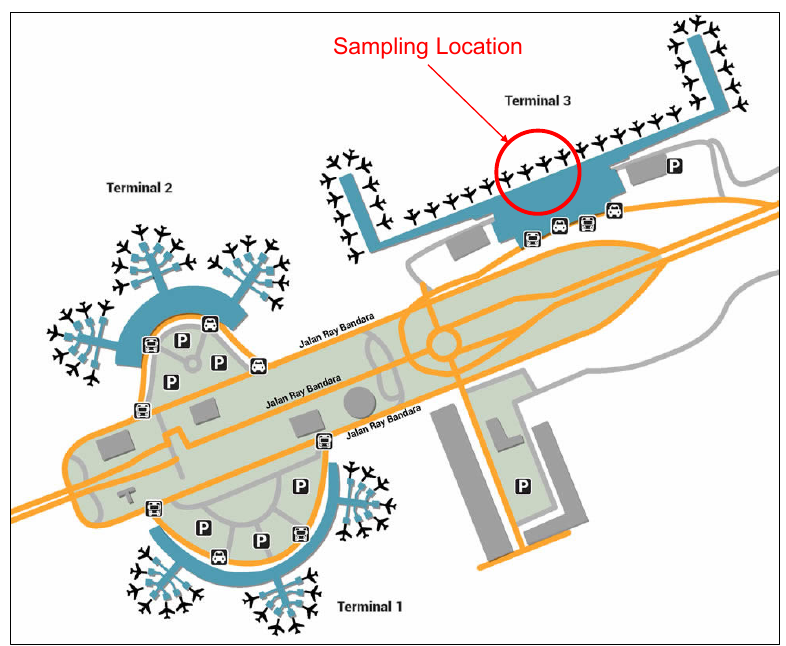
Figure 1. Location of field measurement in the center of Terminal 3 (Image source: https://www.